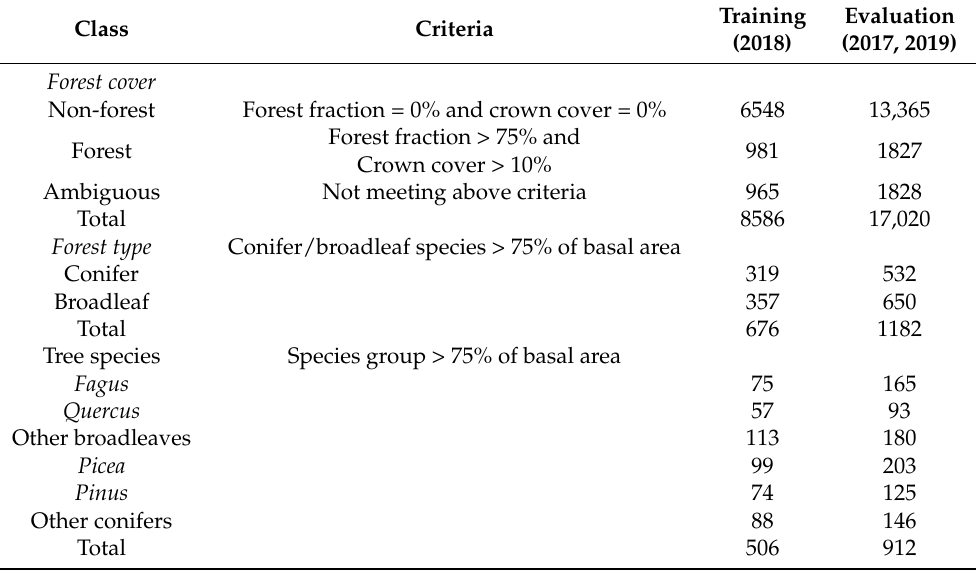
Table 1. Criteria for selecting reference NFI sample plots (SSUs) and number of training/evaluation plots for the different classification tasks, respectively. The fraction of ambiguous plots (i.e., plots that have a forest fraction <75% and/or a crown cover <10%) reflects the fragmented nature of Danish forests. Class Criteria